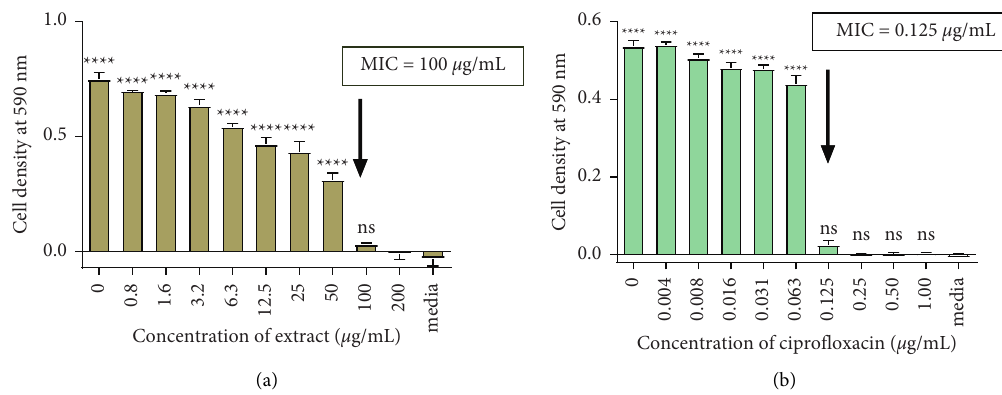
Figure 2: The minimum inhibitory concentration of (a) ethyl acetate extract and (b) ciprofloxacin. All values are expressed as the mean ± SD of four replicates. Statistical one-way ANOVA and Bonferroni’s multiple comparison test (where ∗ < 0 . 05, ∗∗ < 0 . 01, ∗∗∗ < 0 . 001, ns � no significant difference vs. media) show that the lowest concentration where there is no significant difference between media and cells is 100 µ g/ml. Therefore, the MIC for the extract is 100 µ